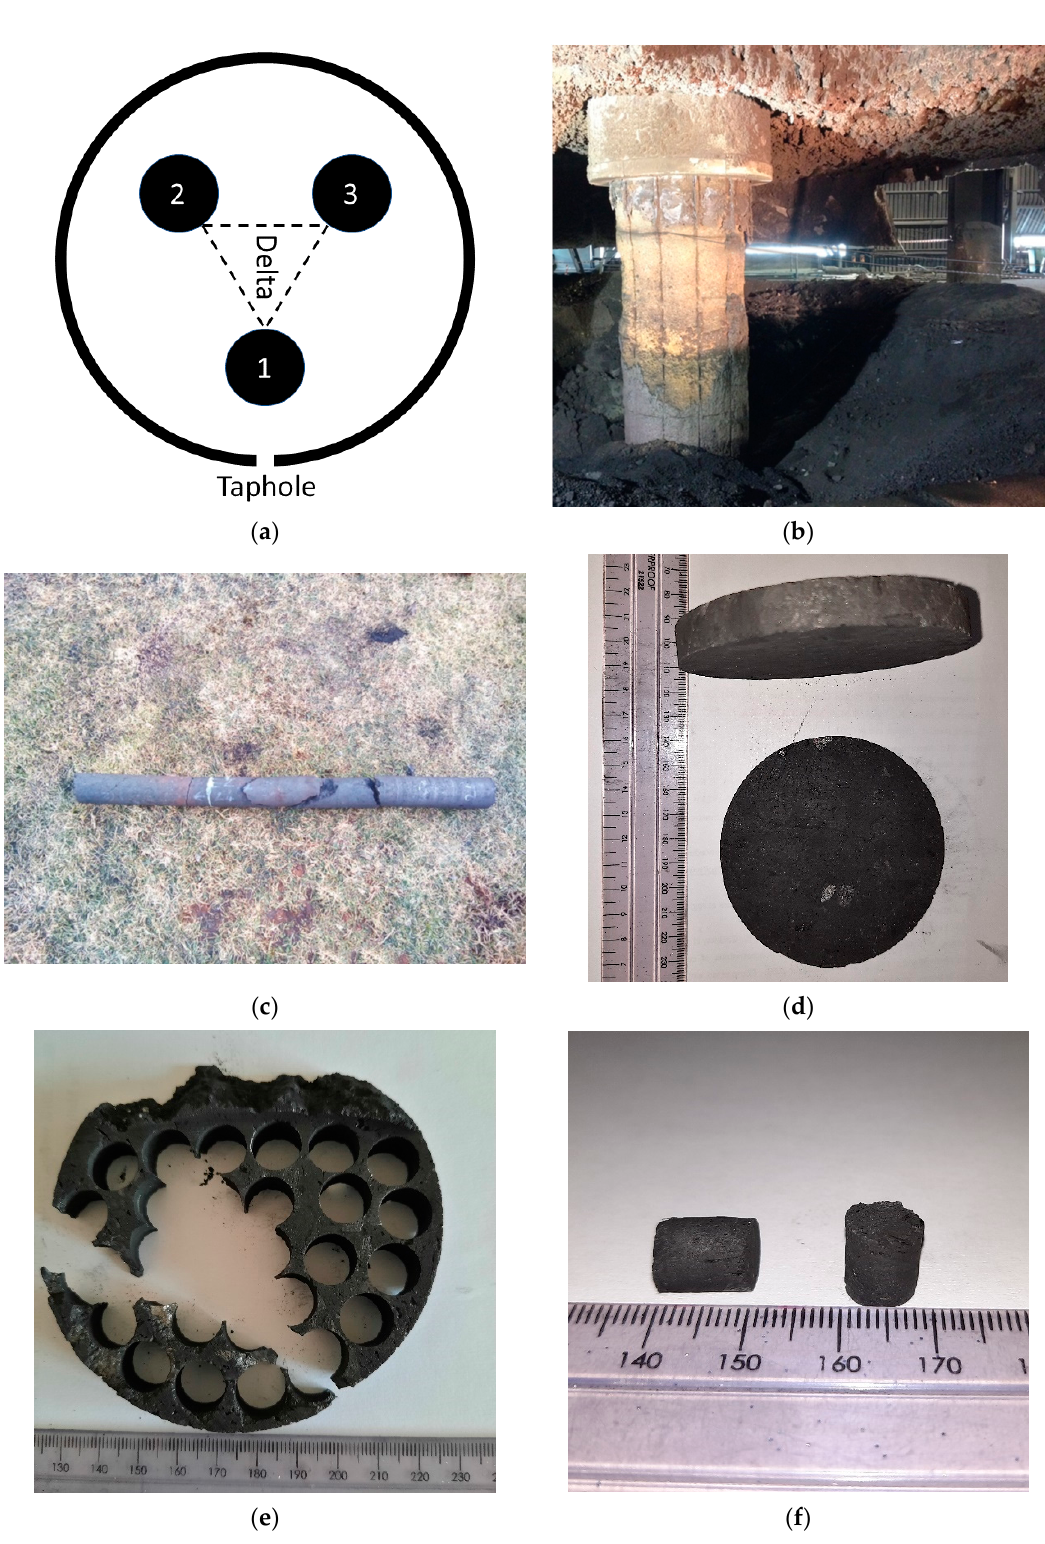
Figure 1. ( a ) Diagram from a top view indicating the electrode numbering of the SAF from which the electrode was removed; ( b ) photo indicating how the electrode was cut off, approximately 0.5 m below the contact shoes with a diamond wire saw; ( c ) an example 100 mm outer diameter core drill sample, collected by core drilling through the entire diameter of the electrode, from the outside towards the delta side of the electrode; ( d ) examples of 10 mm thick disks that were cut from the 100 mm diameter core samples; ( e ) example 10 mm thick disk, after 8 mm outer diameter cylindrical sample pellets were drilled out; ( f ) example 8 mm × 10 mm cylindrical sample pellets that were used in most experiments.